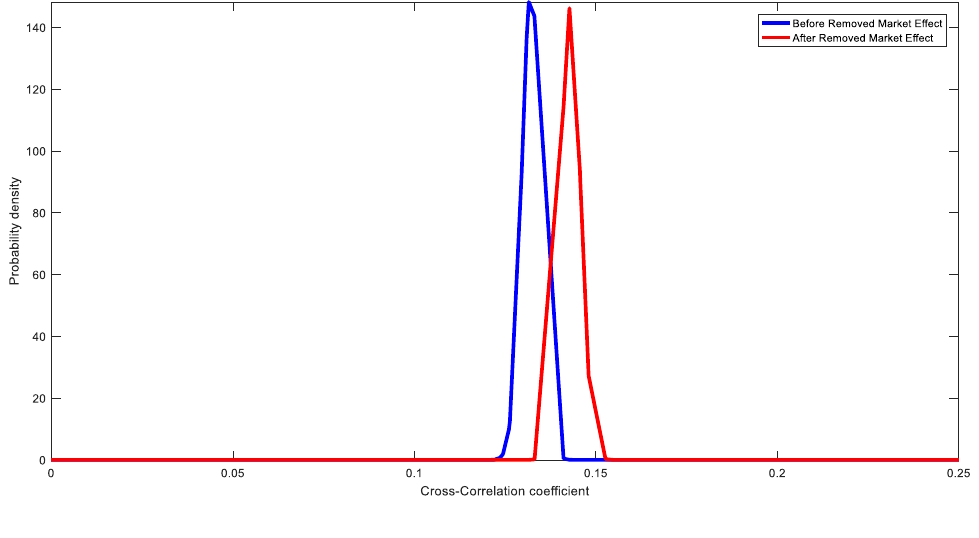
Figure 4. This figure shows that by removing the market-wide effect, only the average of market cross-correlation matrix